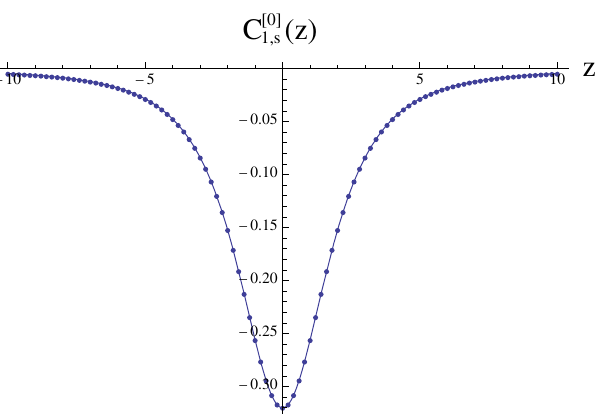
FIG. 8. (Color) The on-axis field component B for the monopole doublet in the case that a ¼ 2 : 5 cm and g ¼ 1 Tesla - ð cm Þ 2 . The coordinate z is given in centimeters.